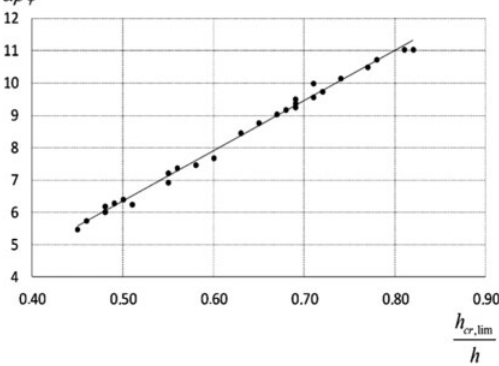
Fig. 4. Relationship between adjustment function a and geometrical characteristics of beams (the correlation coeffi- cient